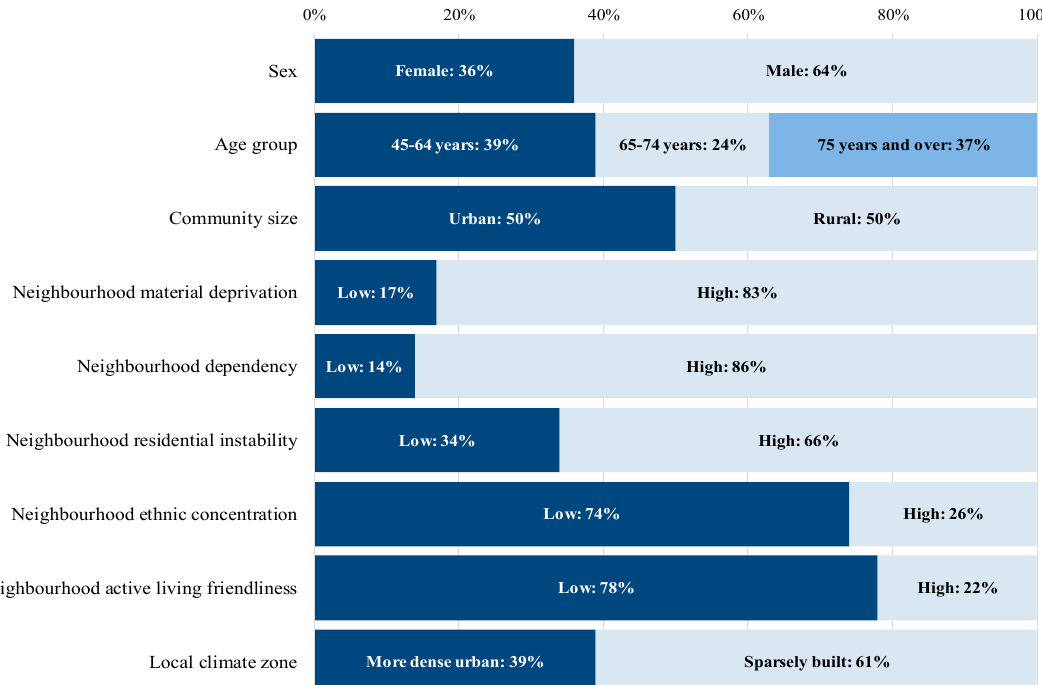
Figure 2. Percentage distribution of the adult population aged 45 and over with prior AMI by individual and neighbourhood-level characteristics, New Brunswick, Canada. Note: Individual and area-based characteristics are those at the time of patient entry to the cohort (N = 13,330 over the baseline period 2003/04 to 2007/08).